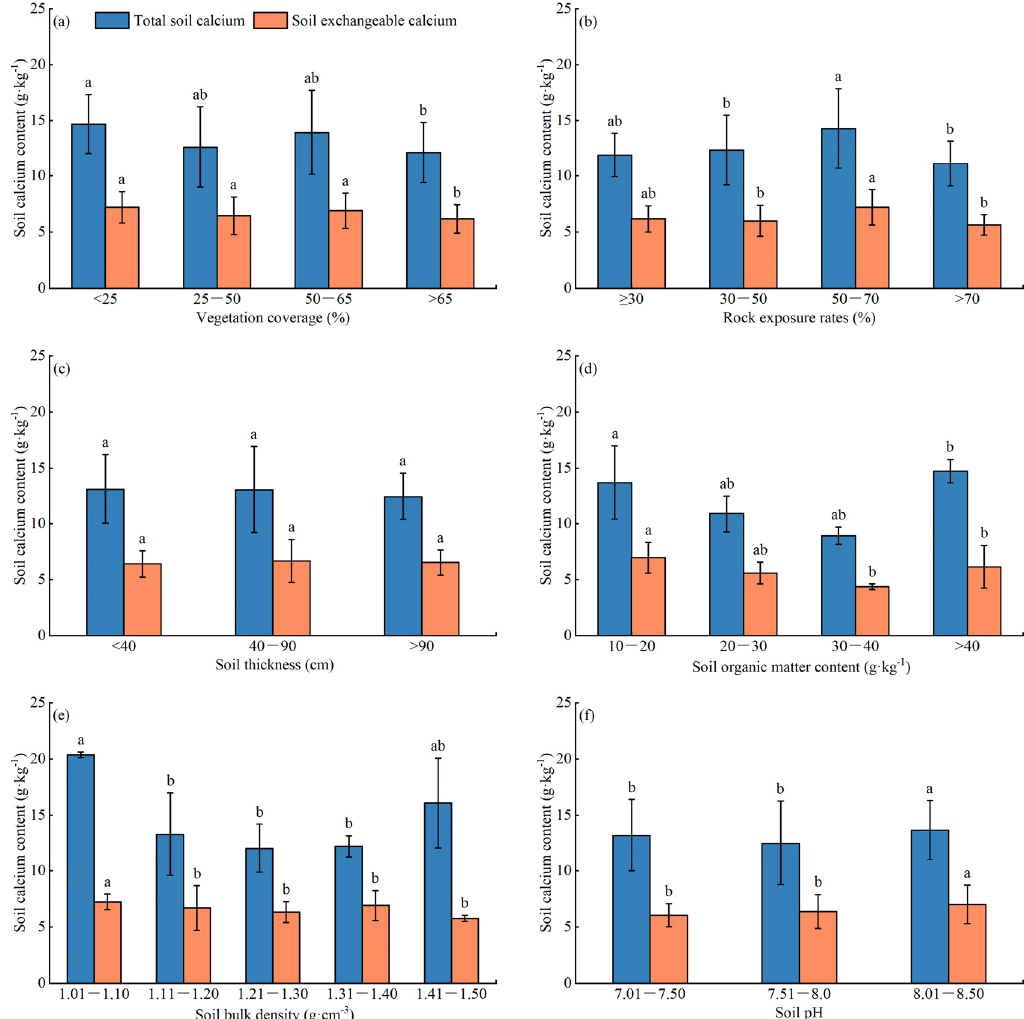
Figure 6. Effects of vegetation coverage ( a ), rock exposure rate ( b ), soil thickness ( c ), soil organic matter content ( d ), soil bulk density ( e ), and soil pH ( f ) on total soil calcium and exchangeable calcium content. Different lowercase letters represent significant differences in soil calcium content ( p < 0.05).